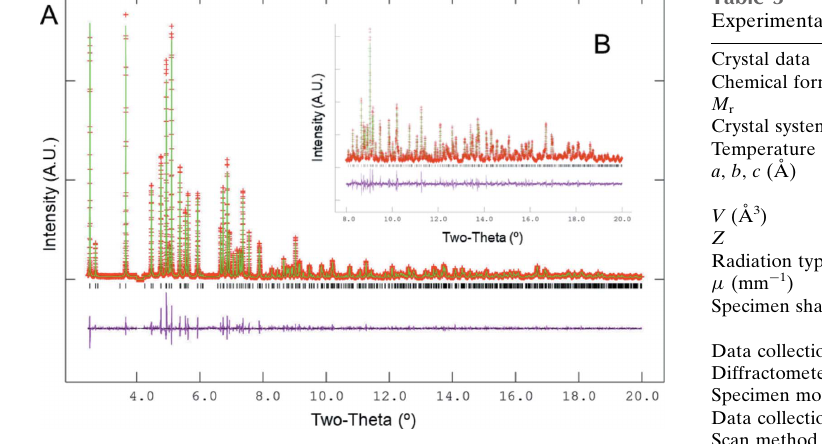
Figure 5 XRD pattern ( (cid:2) = 0.373811 A ˚ ) of (NH 4 ) 3 Al 2 (PO 4 ) 3 synthesized ionothermally in ethyl tributylphosphonium diethylphosphate and Rietveld residuals following structure refinement. Part A shows the fit to the overall pattern, and inset B shows the fit to high-angle